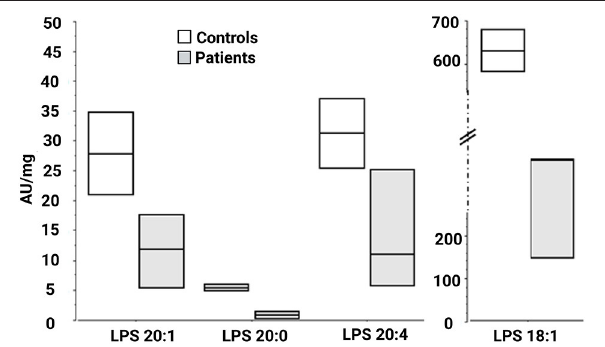
FIGURE 2 | Lysophosphatidylserine molecular species in fibroblasts derived from patients F37-314, F37-315, and F69-508. LPS 18:1, 20:0, 20:1, and 20:4 are lower in the patients than in the healthy controls. AU, arbitrary units; LPS, lysophosphatidylserine.